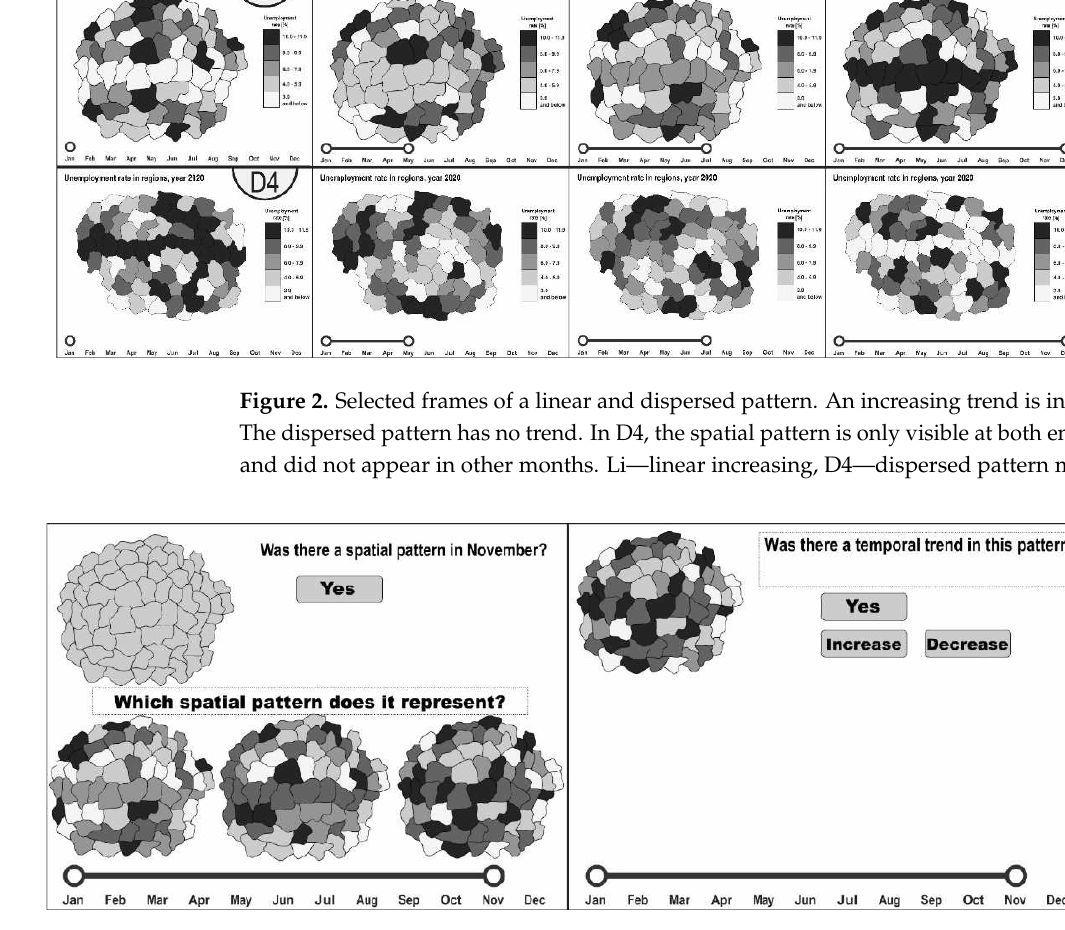
Figure 3. An interactive protocol for the participants’ responses was presented after each animated map